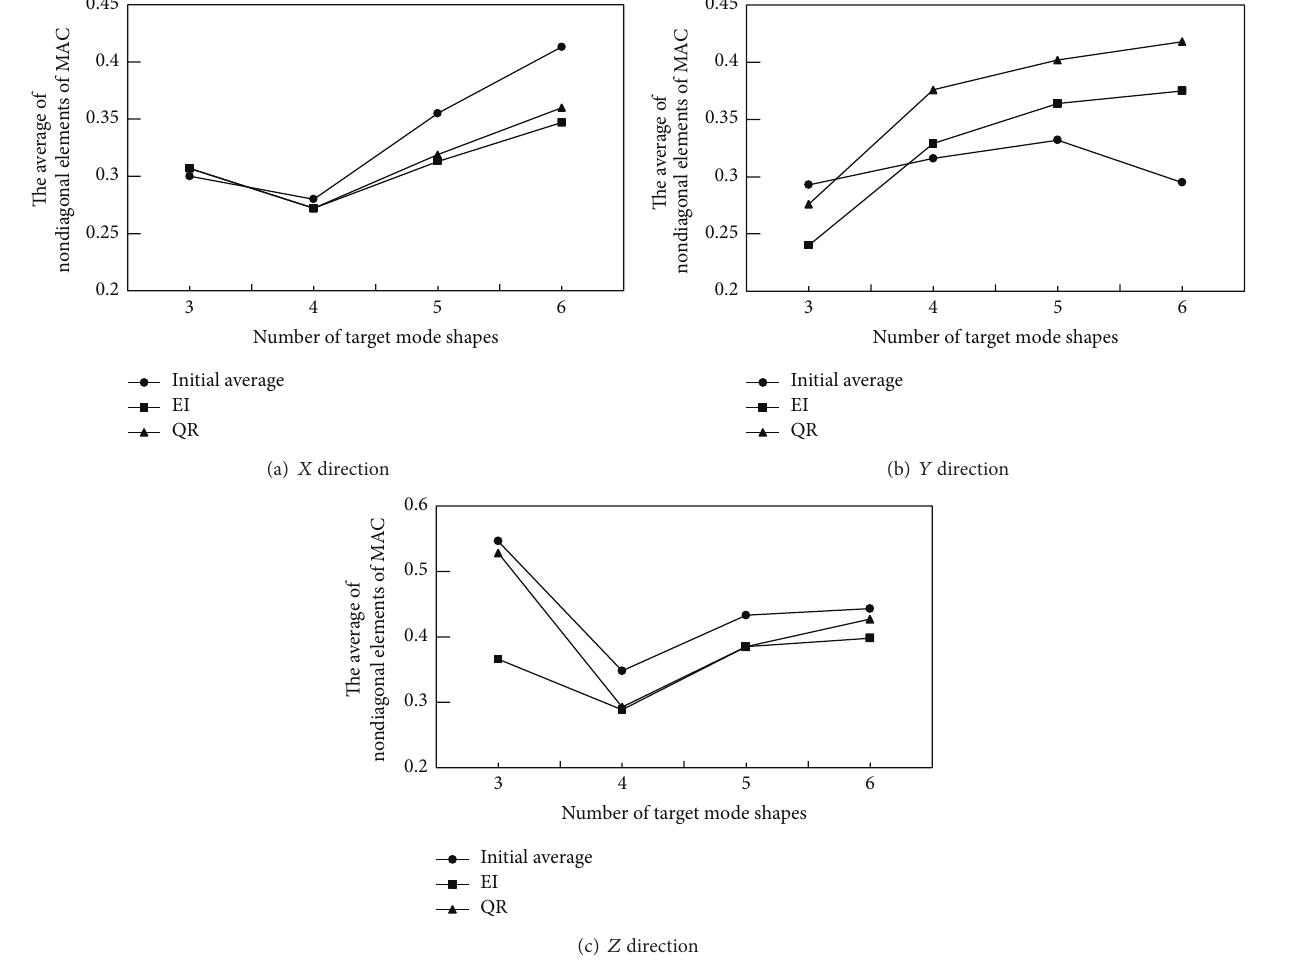
Figure 6: Average values of MAC matrix off-diagonal elements. Table 5: Comparison of vibration displacement between the finite element analysis results and the field test results. Measuring